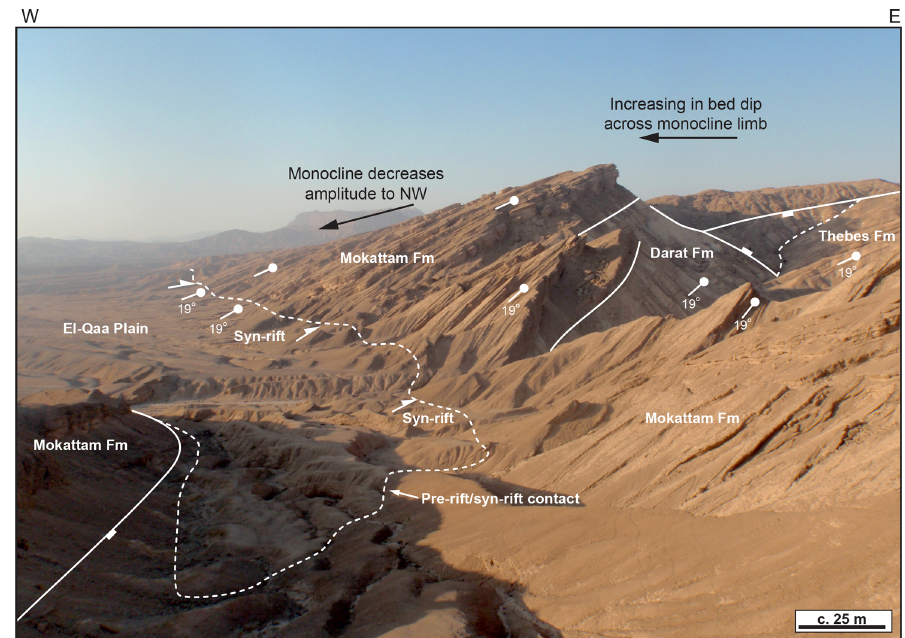
Figure 19. Photograph looking northwards along the middle limb of the East Feiran Monocline Segment. Location of the photo is shown in Fig.